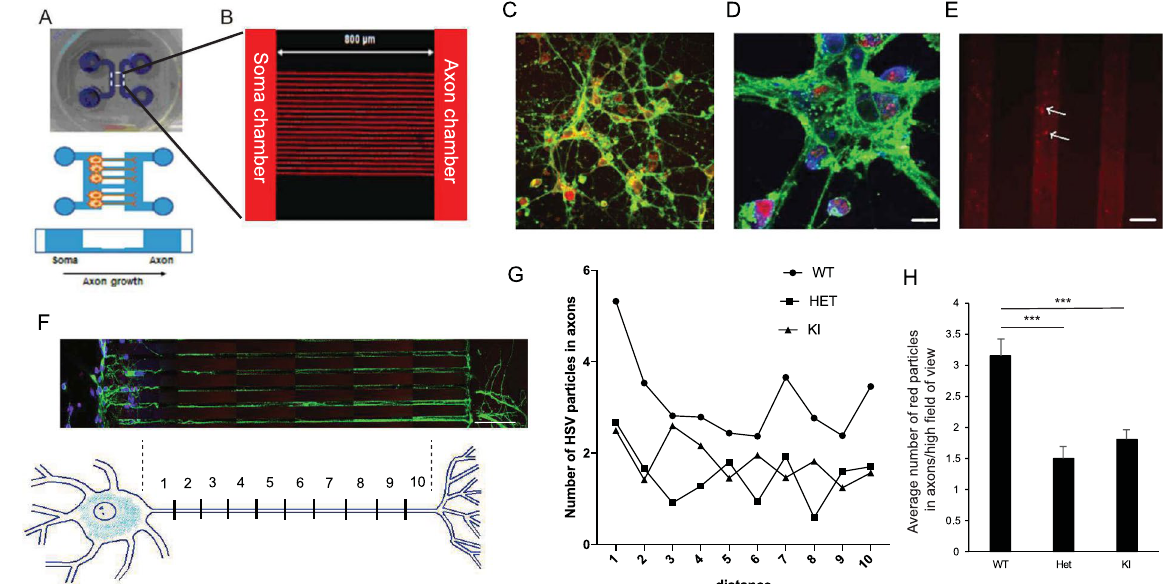
Figure 4. Movement of HSV-VP26-RFP capsids down neuronal axons. Neurons from E15 mouse embryos were plated in microfluidic chambers. ( A and B ) Layout of microfluidic device. ( C and D ) Five days later WT neurons were fixed and stained for tau (green) and DAPI (blue). The virus is shown in the red channel. ( E ) Neurons were infected with HSV-VP26-RFP (M.O.I. of 10) and HSV capsids (red; arrows) were visualized within microgrooves at 8 h post-infection. Scale bars: 30 μ m ( C ), 10 μ m ( D , E ). ( F ) Microscopic image and schematic of the analysis with the axon divided into zones 1 to 10 (each zone length is around ~80 μ m, scale bar is 100 μ m). Microscopic image is a tile scan of 14 images (10 were captured in the microgrooves, two in the cytoplasm and two at the end of the processes). Zone 1 represents the proximal part, while zone 10 is the most distal part of the axon still detectable in the microgroove. ( G ) Number of virus particles in different axonal zones. No significant trend was found for any genotype (linear regression analysis, R 2 is 0.21, 0.08 and 0.34 for WT, Het and KI, respectively, not significantly different using F-test (p = 0.18, p = 0.40, p = 0.07 for WT, Het and KI, respectively)). ( H ) Overall, throughout the axons (average of zones 1 to 10) there were significantly higher numbers of virus capsids in the WT neurons than either the Het or KI neurons, (p < 0.001, ANOVA followed by Tukey’s post hoc test) (WT: n = 6 embryos, Het: n = 6 embryos, KI: n = 5 embryos; 6 axons per embryo were analyzed and 10 images captured per axon, in 3 separate